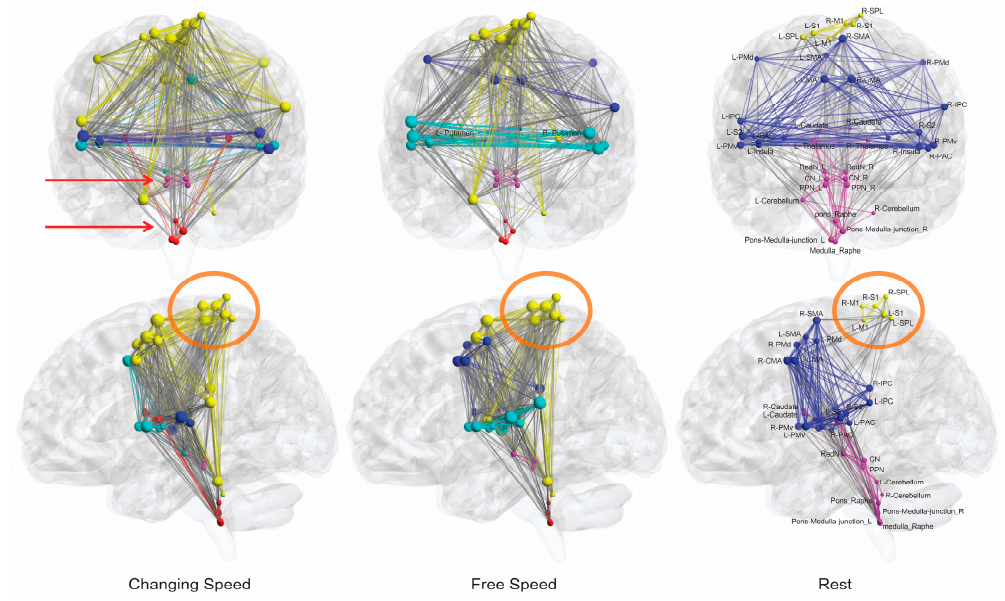
Figure 2. Networks in anatomical space. Edges are sized according to their weight, and brain regions are sized according to nodal strength (the sum of weights of all edges connected to this region). The smaller size of nodes and finer edges in the sparser resting-state network indicate lower nodal strength, weaker internodal connections, and lesser interactions. The brain regions in the same module are indicated in the same color. Bilateral midbrain nodes and pons–medulla nodes constitute two separate modules (red arrows) under all motor task conditions (see Supplementary Materials Figure S5 for all conditions and Supplementary Materials Figure S6 for network layout). The M1–S1–SPL group (orange circles) constitutes a module during resting state that extends to other brain regions in all task conditions. There are no links between this group and brainstem nodes during the resting state (shown in the second row of the rightmost column).